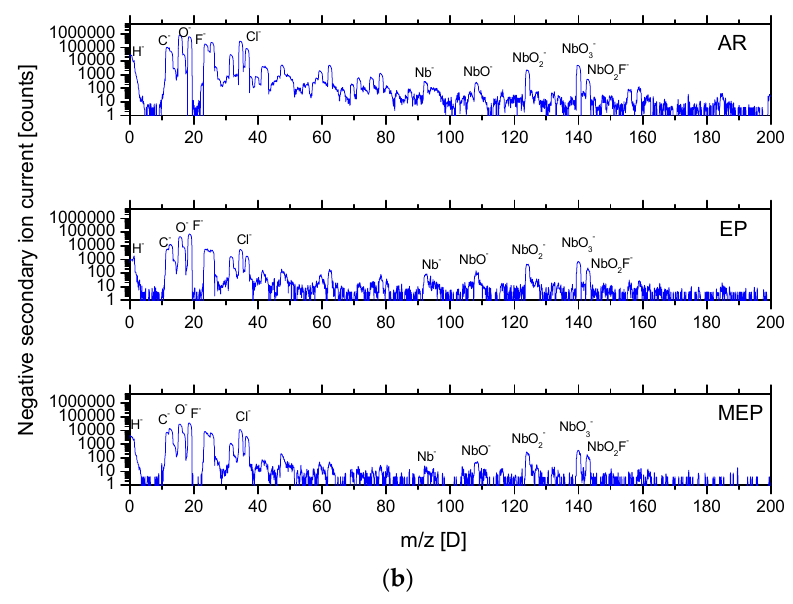
Figure 2 . Mass spectrograms of positive ( a ) and negative ( b ) secondary ion currents. Results taken of three niobium samples: AR, EP, and MEP are presented.